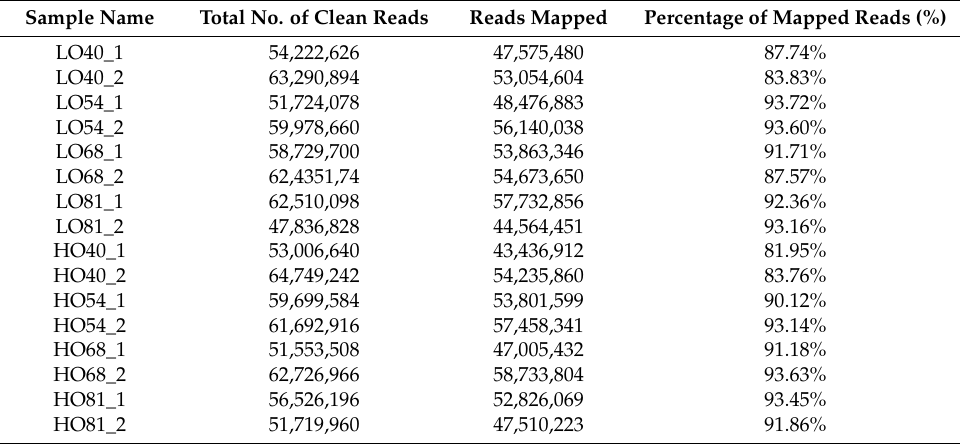
Table 2. Summary of clean reads aligned to the reference transcriptome for each